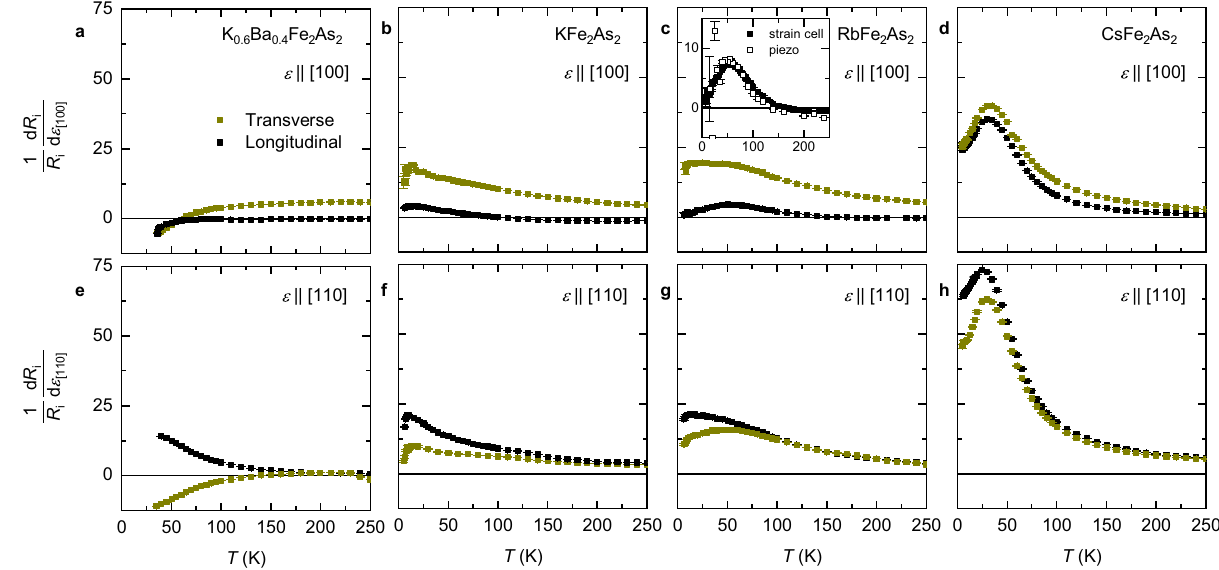
Fig. 2 Elastoresistance of strongly hole-doped iron-based superconductors. Longitudinal and transverse elastoresistance with the strain direction ϵ ∥ [100] ( a – d ) and ϵ ∥ [110] ( e – h ) for indicated samples arranged by column. Error bars indicate one standard deviation of a linear fi t. The inset of xx xx c shows a comparison of strain-cell-based and piezoelectric stack-based longitudinal elastoresistivity measurements for RbFe 2 As 2 with ϵ xx ∥ [100]. The strain-cell data have been scaled to account for strain relaxation in the epoxy (see “ Methods ” and Supplementary Fig.